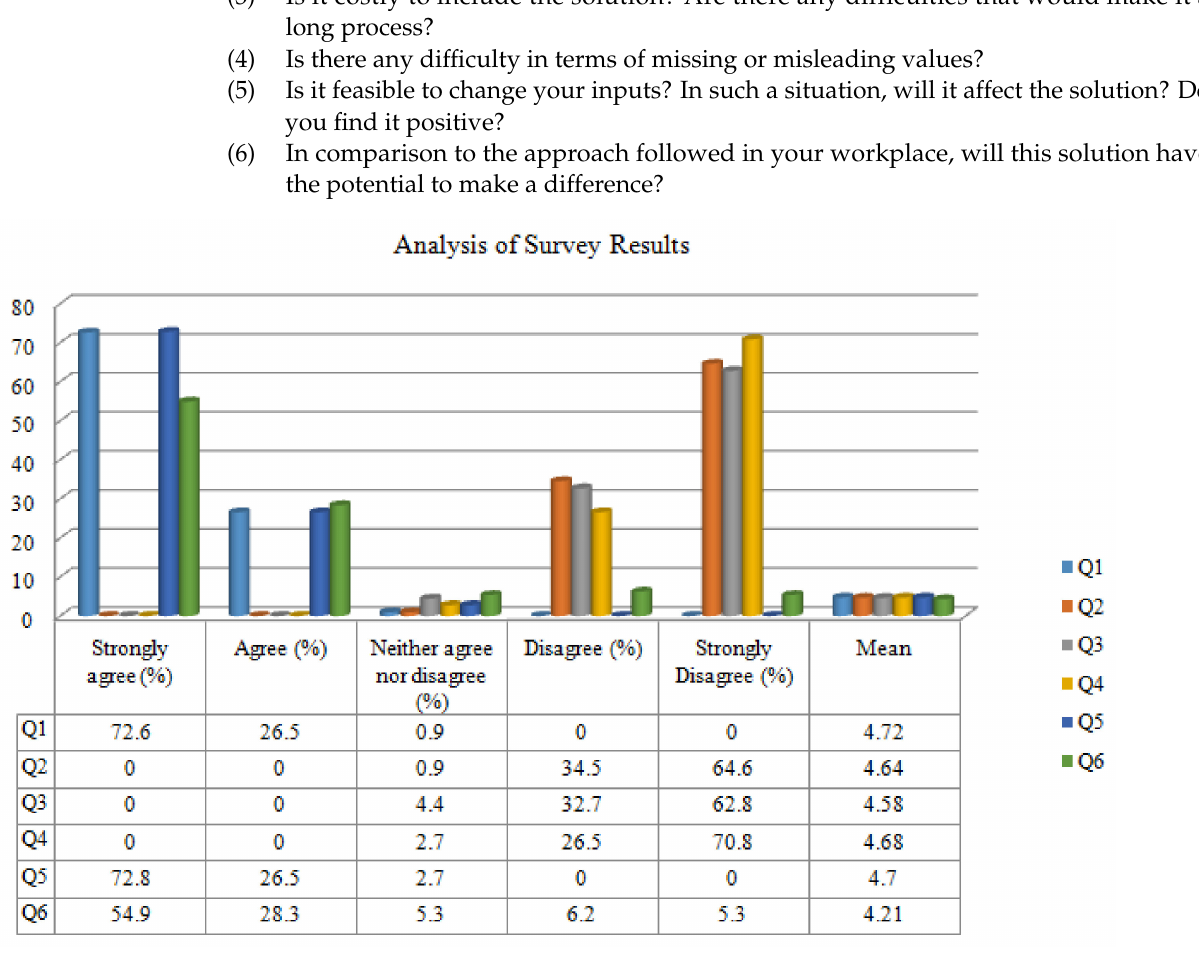
Figure 3. Analysis of survey